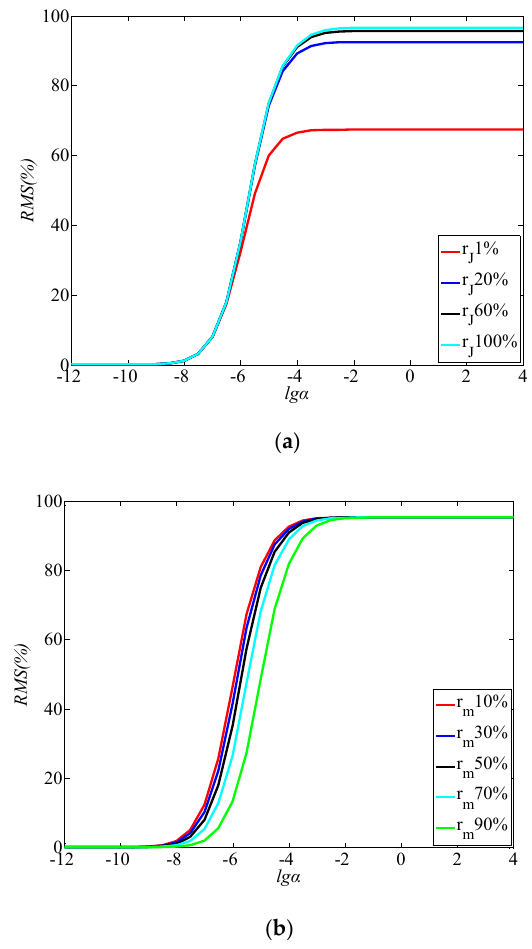
Figure 3. Effect of α on control effectiveness: curves of RMS . Figure 3. E ff ect of α on control e ff ectiveness: curves of RMS